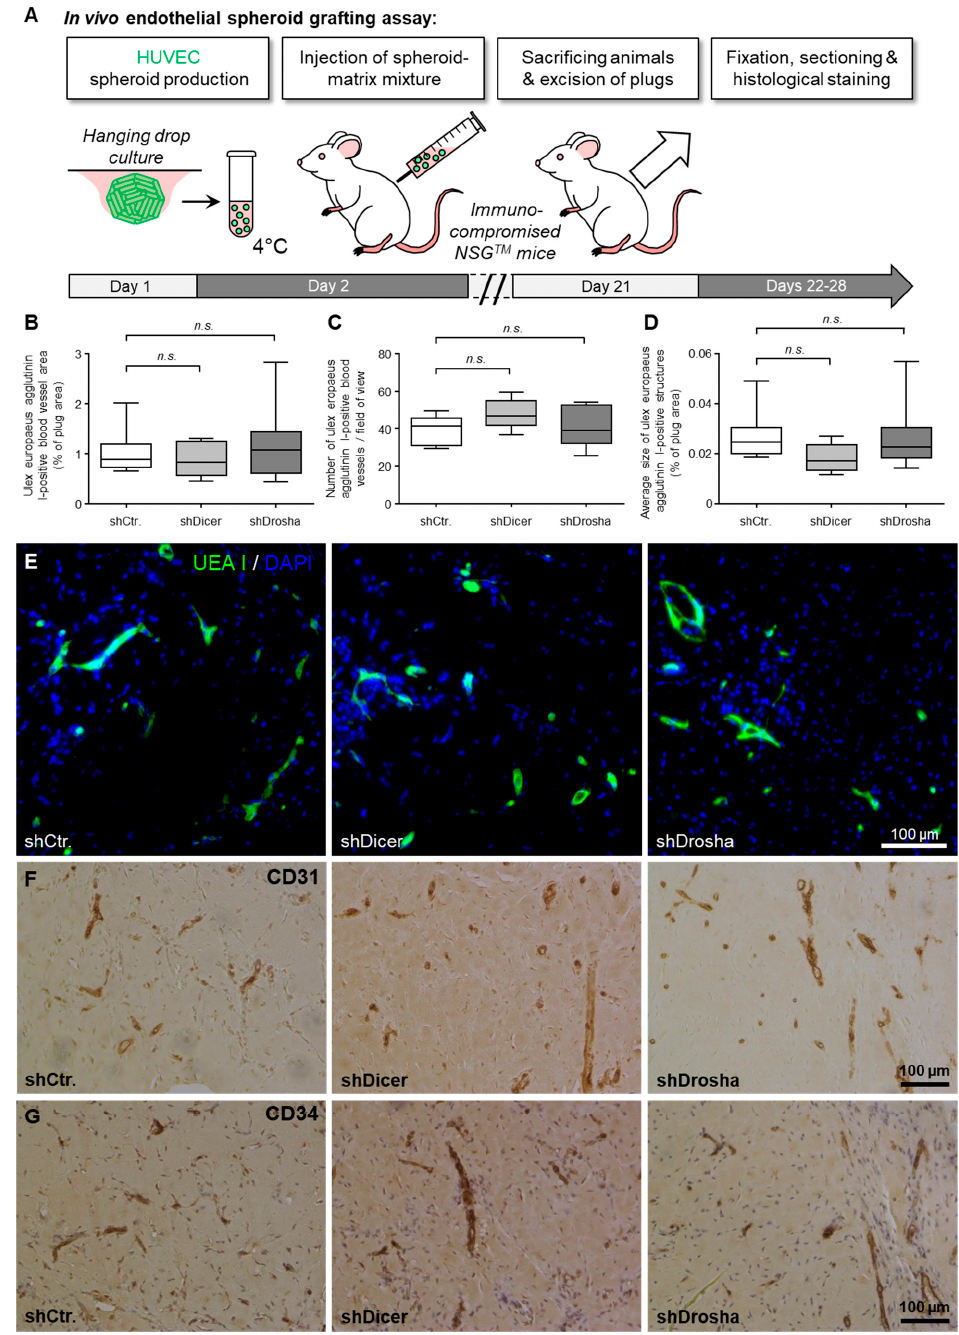
Figure 3. Impact of RNAi-mediated knockdown of DICER1 or DROSHA on the angiogenic capacity of HUVEC in vivo . ( A ) Schematic illustration of the experimental setup of the HUVEC spheroid-based grafting assay in immunodeficient NSG TM mice. ( B – D ) shRNA-mediated knockdown of DICER1 or DROSHA in HUVEC does not affect VEGF- and bFGF-induced blood vessel growth of these cells in vivo as compared to non-targeting shRNA-expressing control HUVEC ( n = 7–9 xenograft plugs). n.s. denotes non-significant. Blood vessel growth was analysed by quantification of the Ulex